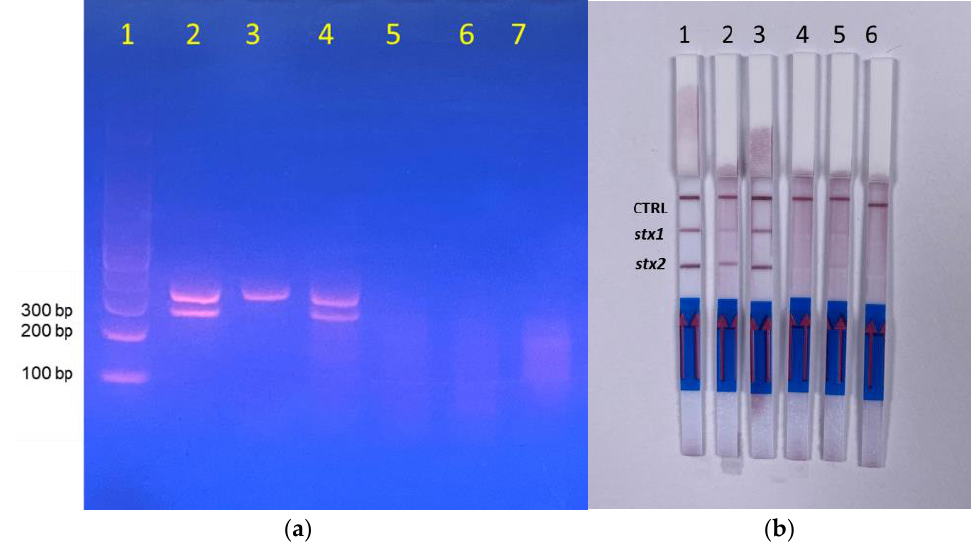
Figure 2. ( a ) Agarose gel visualization of amplified DNA, Lane 1: 100 bp ladder, Lane 2: E. coli O157: H7, Lane 3: E. coli O121, Lane 4: E. coli O26, Lane 5: P. aeruginosa , Lane 6: E. coli O6, Lane 7: Negative control ( b ) Lateral flow assay visualization of the same RPA products at concentrations of 10 6 CFU/mL. 1: E. coli O157:H7, 2: E. coli O121, 3: E. coli O26, 4: P. aeruginosa , 5: E. coli O6, 6: Negative control.